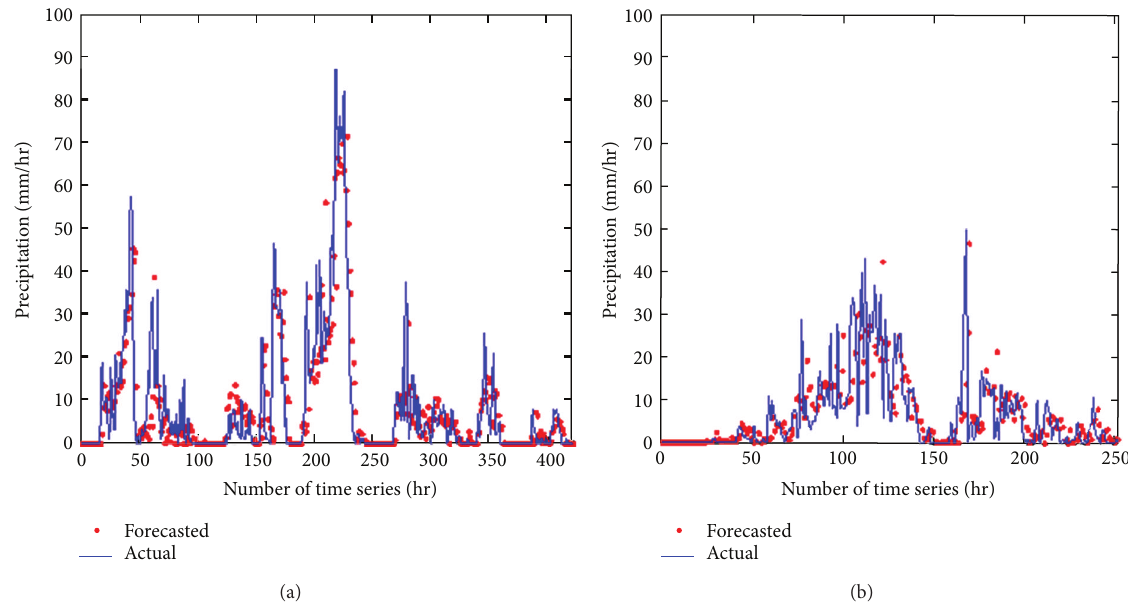
Figure 18: The validation and testing precipitation forecast results at 𝑡+2 of the ANFIS-based coupled hybrid dual-model at Yu-Feng station: (a) validation; (b) testing.